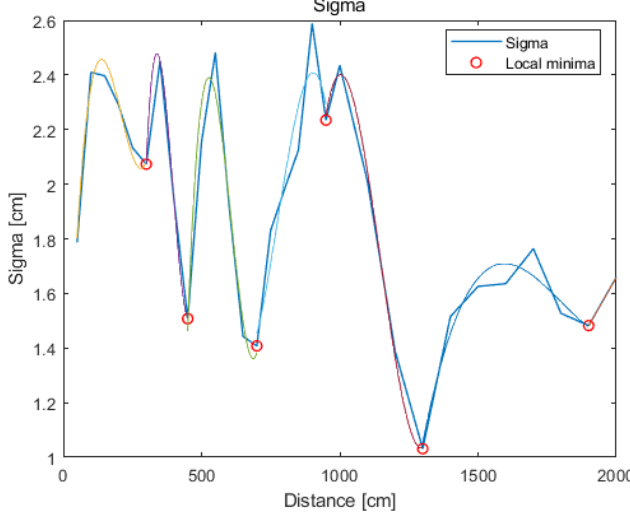
Figure 11. A polynomial approximation of the standard deviation.